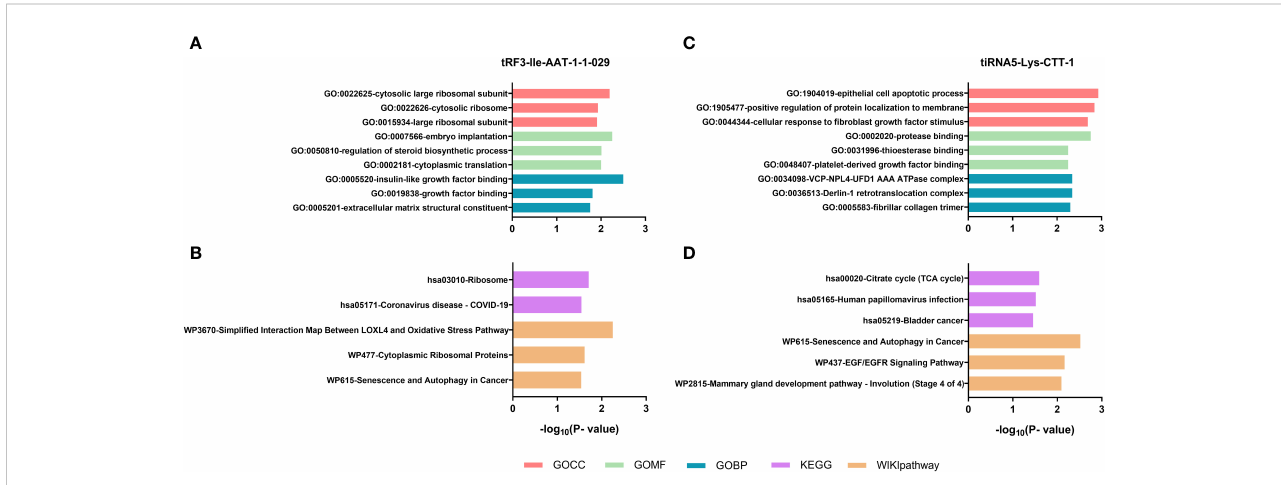
FIGURE 7 Enrichment analysis of tRF3-Ile AAT-1 and tiRNA5-Lys-CTT-1. GO terms analysis of tRF3-Ile AAT-1 (A) . Signal pathway analysis of tRF3-Ile AAT-1 (B) . GO terms analysis of tiRNA5-Lys-CTT-1 (C) . Signal pathway analysis of tiRNA5-Lys-CTT-1 (D) .